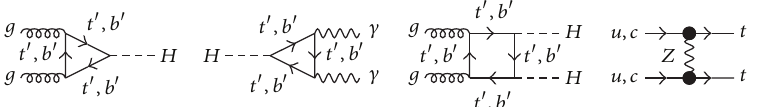
Figure 8: Feynman diagrams for processes with VLQs contributions. From left to right: Higgs production through gluon fusion, Higgs to two-photon decay, Higgs pair production, and FCNC same-sign top